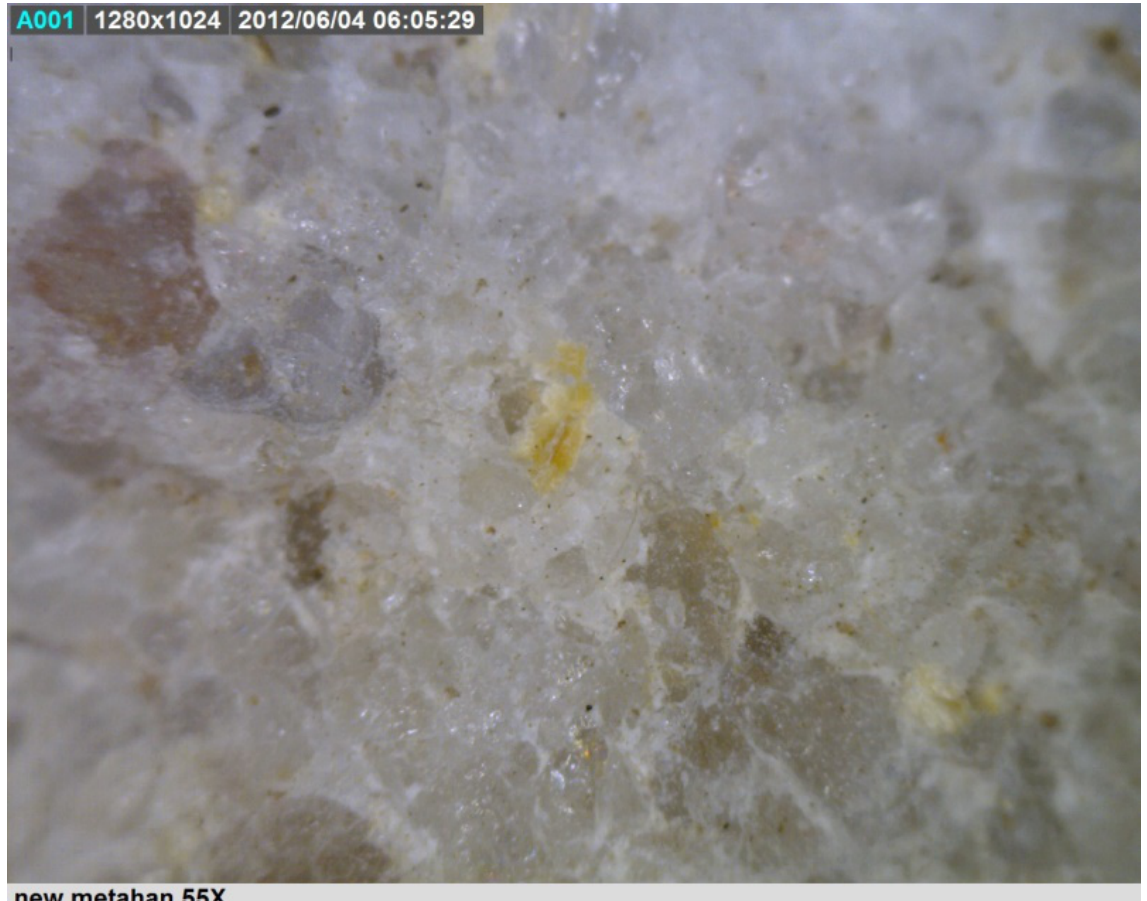
Figure 4. The raw material used for production – quartzitic